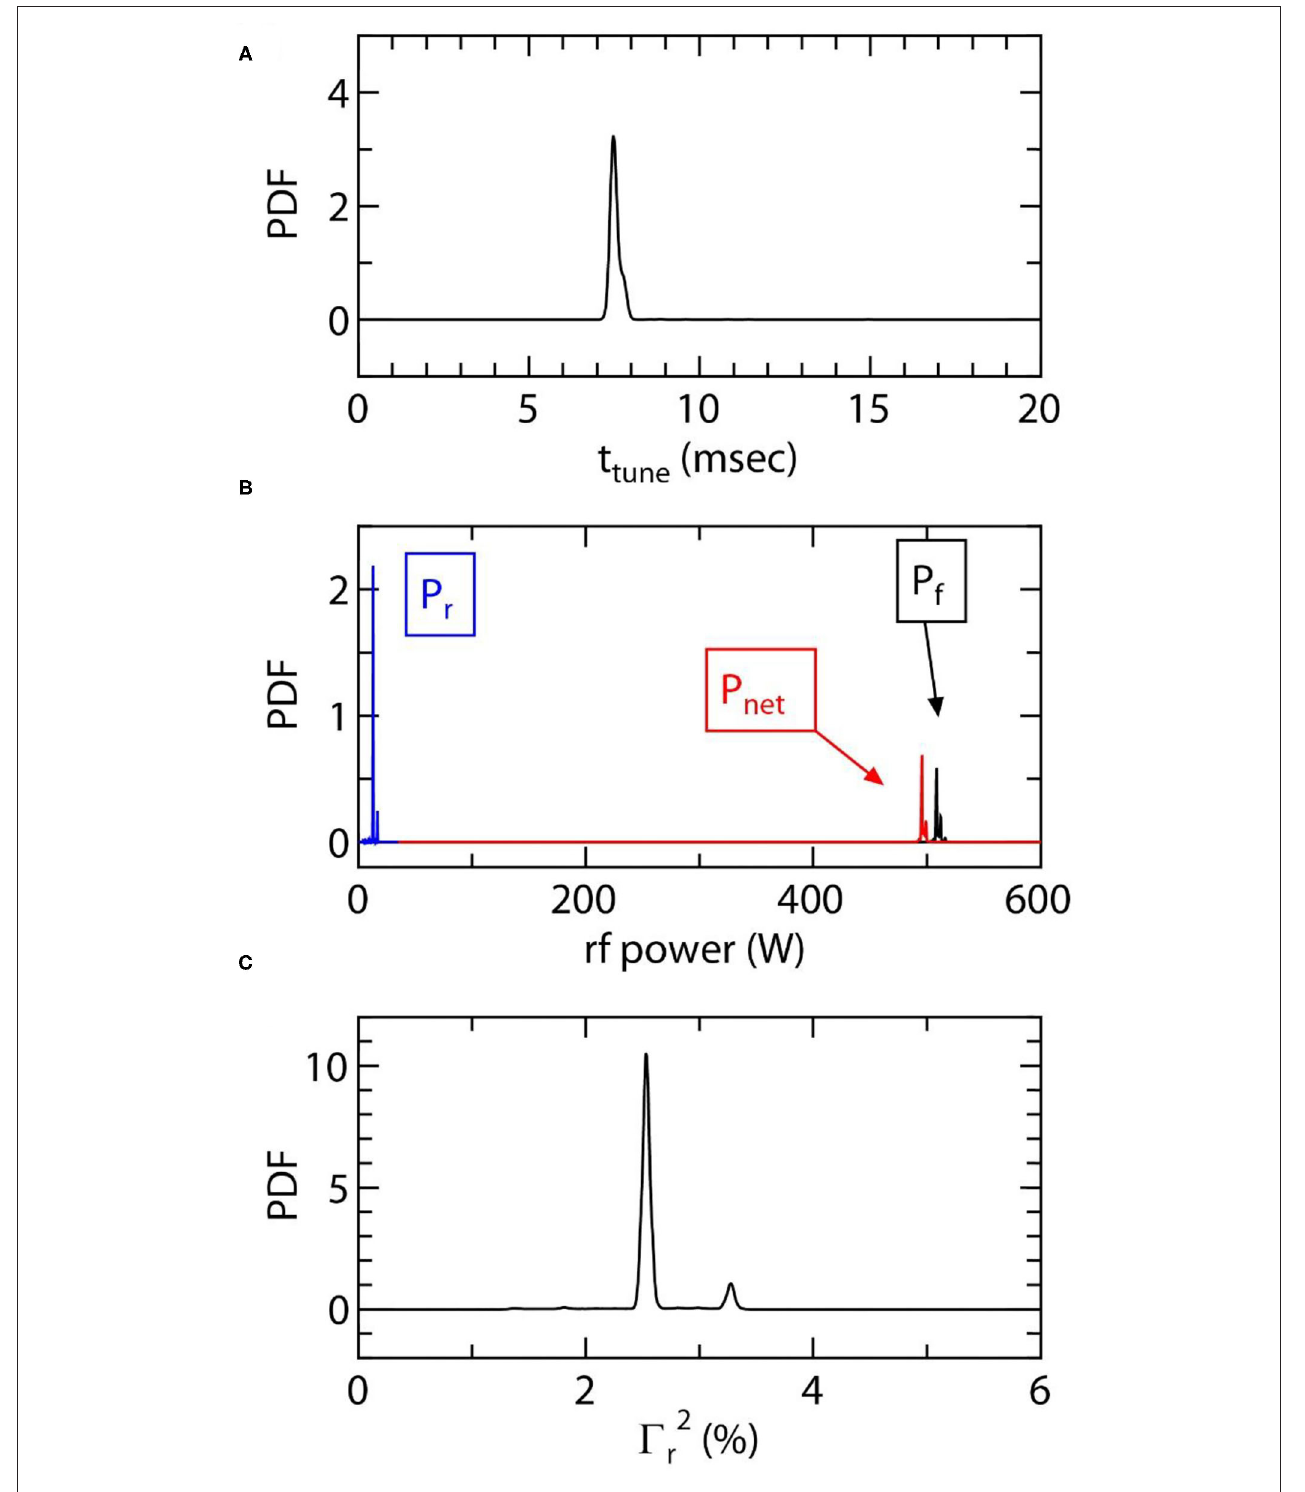
FIGURE 4 | Probability density functions (PDFs) of (A) the tuning time t tune , (B) the forward power P f (a black solid line), the reflected power P r (a blue solid line), the net power P net (a red solid line), and (C) the square of the reflection coefficient Γ 2 r . These are obtained from the data taken by 1,000 shots repetition.